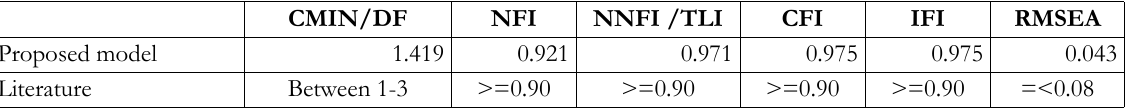
Table 2. Goodness of fit indices for the proposed model and cuts marked by the literature.